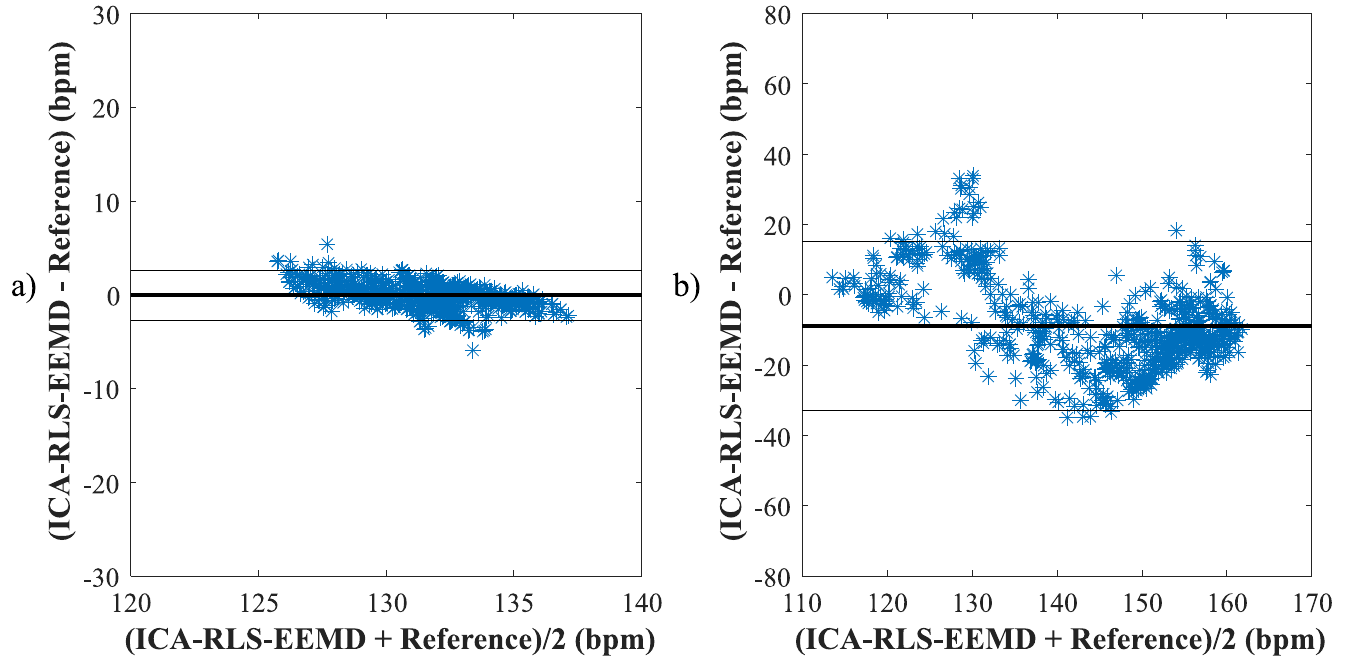
Fig 8. Comparison of reference and estimated values using the ICA-RLS-EEMD method when determining the fHR a) for recording r09 and b) for recording r11 based on the Bland-Altman plots.